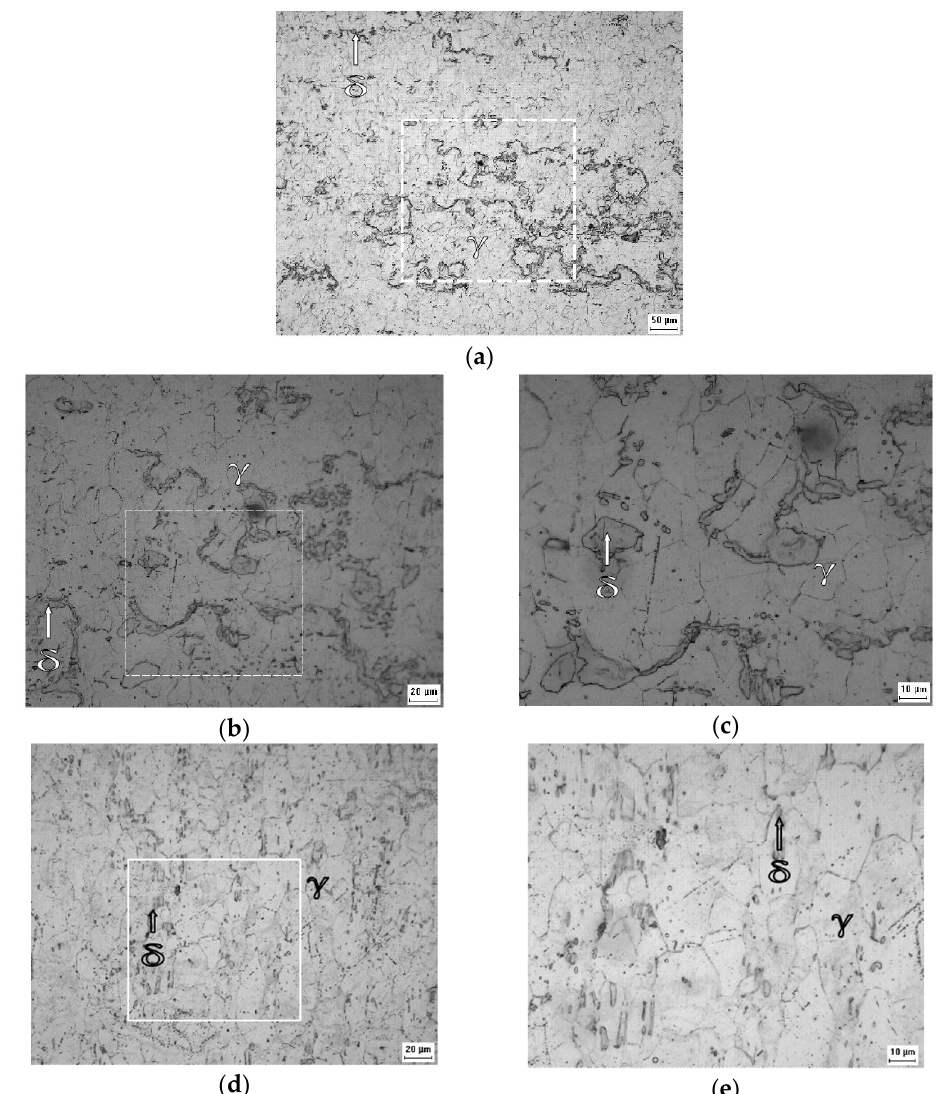
Figure 4. Micrographs obtained by optical microscopy of the B0 sample at ×200 ( a ) and ×500 ( b ) of magnification after the Behara’s reagent attack.